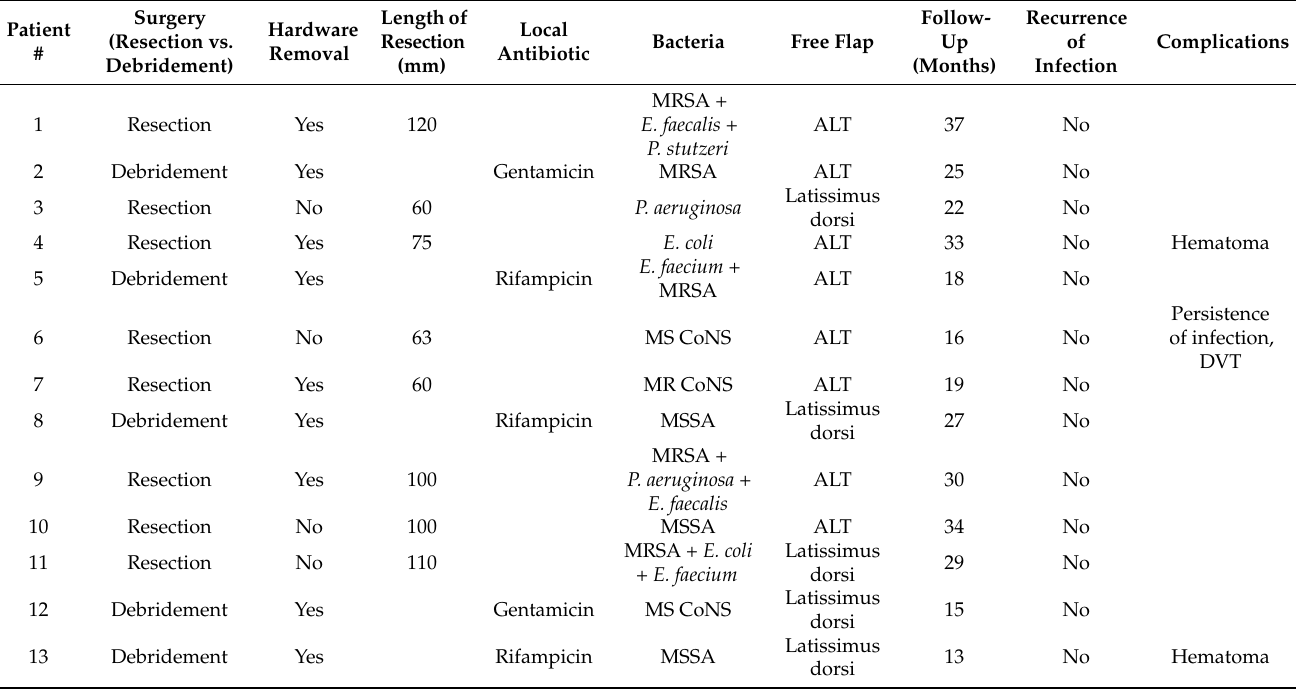
Table 2. Treatment and follow-up data. MR: methicillin-resistant; MS: